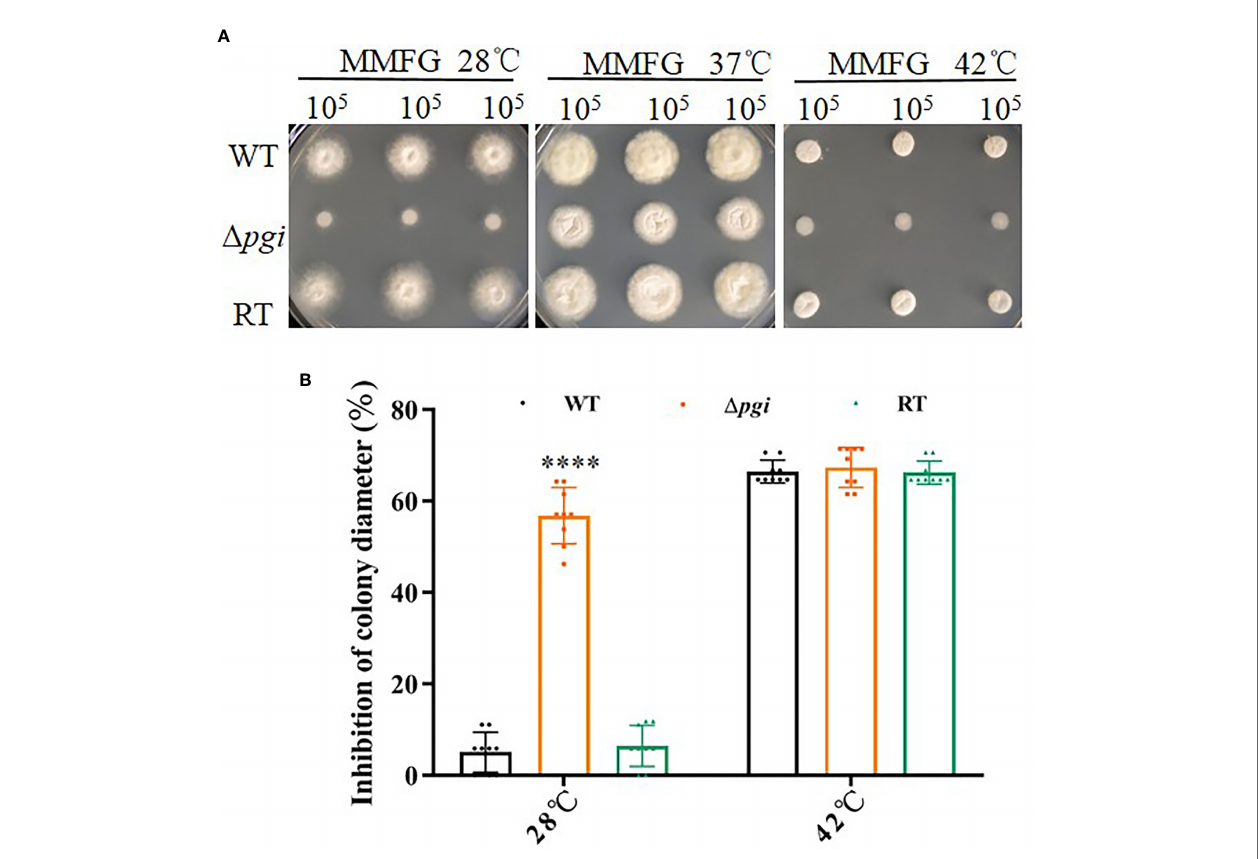
FIGURE 5 | Growth of the mutant at various temperatures. (A) 10 5 conidia of the WT, D pgi , and RT strains were grown on MMFG medium at 28°C, 37°C, or 42°C for 2 days; (B) Growth rate was calculated based on the colony diameter of the strains grown at 28°C or 42°C as compared with that at 37°C. Values are presented as mean ± SD of three replicates, and multiple t tests were used for statistical signi fi cance (**** p <